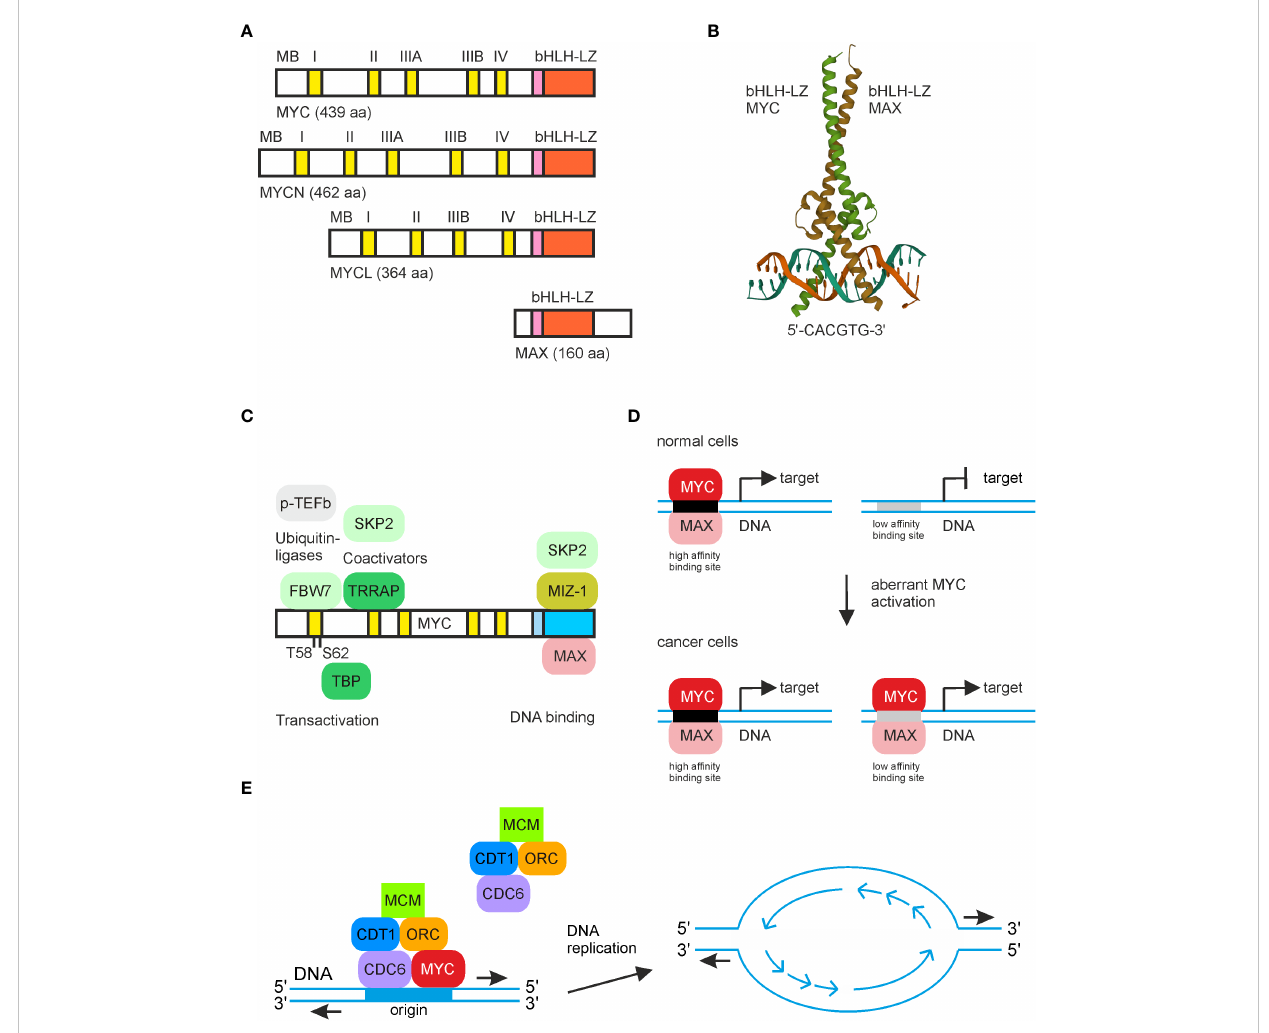
FIGURE 1 MYC structure and relevant protein and DNA interactions. (A) Schematic depiction of the human MYC paralogs MYC (c-Myc), MYCN (N-Myc), and LMYC (L-Myc) and of human MAX. The conserved dimerization and DNA binding regions (bHLH-LZ) in the carboxyl-terminal regions are depicted in pink/orange, and the MYC boxes (MB) in the amino-terminal transactivation regions are in yellow. (B) Structure of the human MYC/MAX bHLH-LZ domains binding to the E-box (5 ′ -CACGTG-3 ′ ). The image was created from the PDB entry 1NKP. (C) Selected MYC protein interaction partners and their positions where they bind the MYC protein surface. (D) Simpli fi ed illustration of the transcriptional ampli fi cation model. At low MYC concentrations, only high-af fi nity binding sites are occupied, leading to transcriptional regulation of target genes. At high MYC levels, as it occurs in most cancer cells, also targets with low-af fi nity binding sites are bound by MYC, causing aberrant expression of cell transformation-associated MYC target genes. (E) Scheme showing MYC interactions with proteins of the pre-replicative complex at the onset of DNA replication leading to initiation of bidirectional DNA